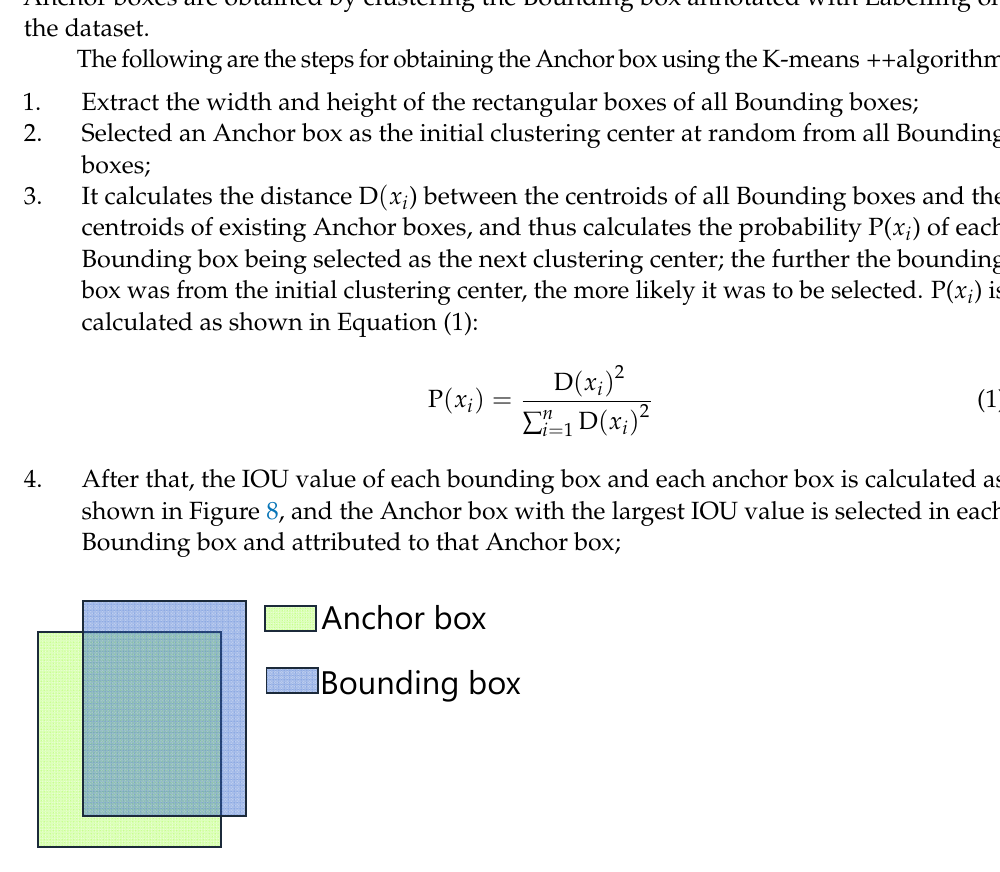
Figure 8. Calculation of the IOU.